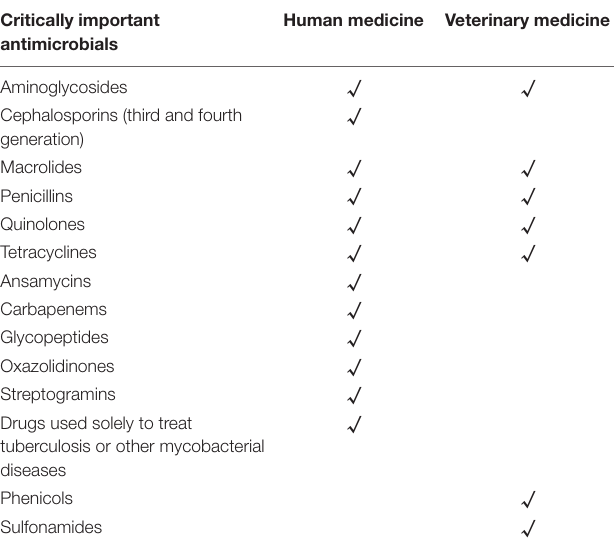
TABLE 3 | Comparison of the human and veterinary critically important antimicrobials (CIAs) list (FAO/WHO/OIE, 2017). Critically important Human medicine Veterinary antimicrobials